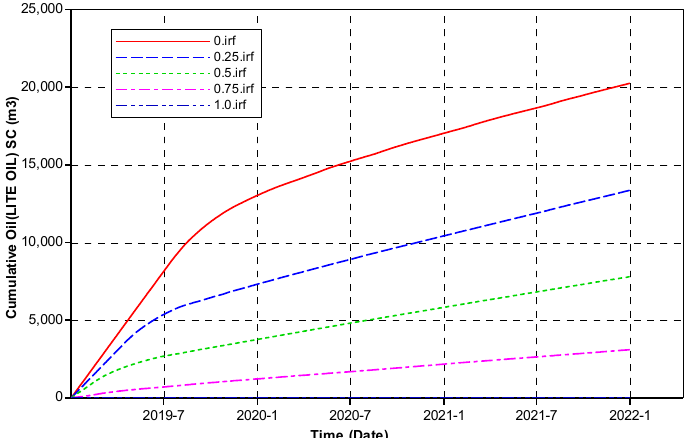
Figure 8. Cumulative production of heavy component after steam flooding at different proportion of components.